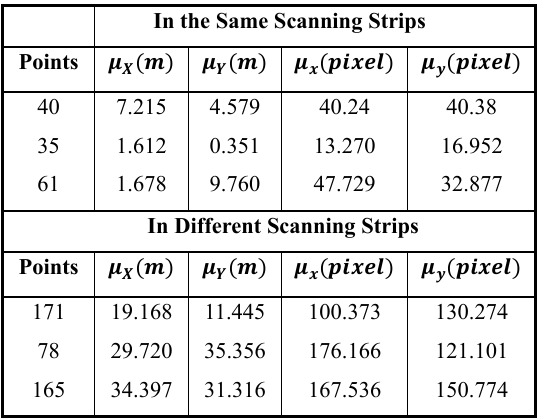
Table 5. Relative Accuracy of